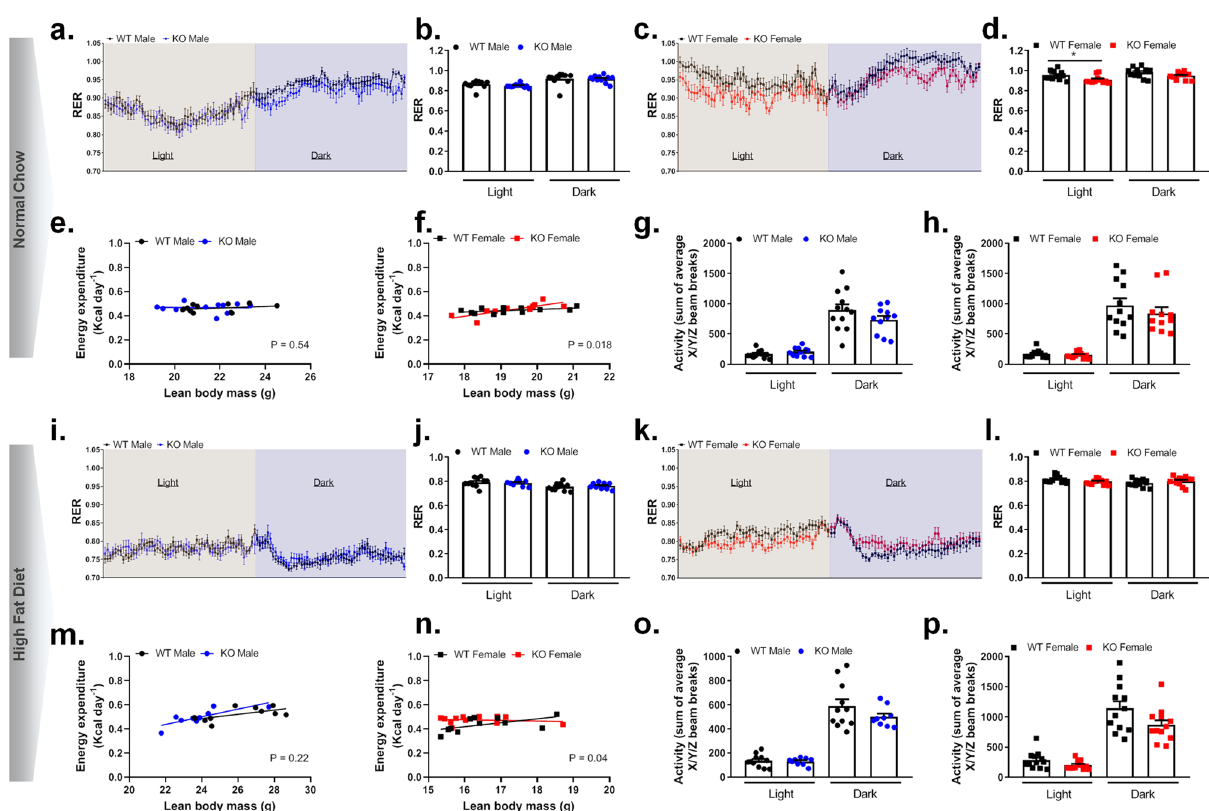
Fig. 4 Whole body respirometry in male and female WT and adi-KO mice fed a chow or high-fat diet. Trim28 wild type (WT) and adipose-speci fi c Trim28 KO (KO) male and female mice were placed in metabolic cages (CLAMS) at 11 weeks of age (5 weeks post diet) for ~2 days. Respiratory exchange ratio (RER) over 24 h for chow-fed ( a ) male and ( c ) female mice, and average RER for light and dark periods for ( b ) male and ( d ) female mice. Energy expenditure assessed by ANCOVA (analysis of covariance) over 24 h for ( e ) chow-fed male and ( f ) female mice, and average activity, calculated as the sum of the average X / Y / Z beam breaks, for ( g ) male and ( h ) female chow-fed mice during light and dark periods. Respiratory exchange ratio (RER) over 24 h for ( i ) HFD-fed male and ( k ) female mice, and average RER for light and dark periods for ( j ) HFD-fed male and ( l ) female mice. Energy expenditure assessed by ANCOVA over 24 h for ( m ) HFD-fed male and ( n ) female mice, and average activity, calculated as the sum of the average X / Y / Z beam breaks, for ( o ) male and ( p ) female mice during light and dark periods. All data are represented as mean ± SEM, * p < 0.05 versus WT; p < 0.05 considered signi fi cant for ANCOVA analysis of energy expenditure. Chow-fed mice: female mice n = 11 WT and n = 11 KO, and male mice n = 12 WT and n = 11 KO. HFD-fed mice: female mice n = 12 WT and n = 12 KO, and male mice n = 11 WT and n = 9 KO. RER respiratory exchange ratio, (g)